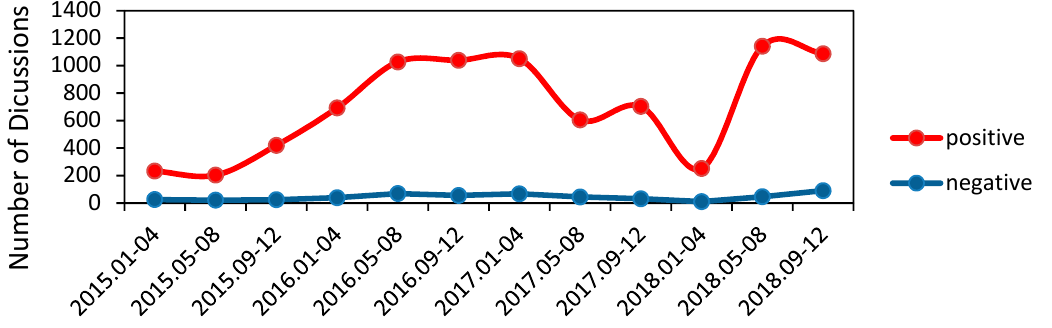
Figure 2. Overall emotional time series.